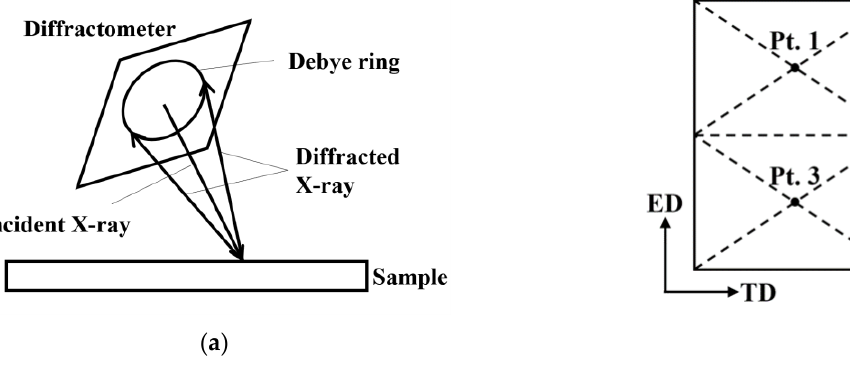
Figure 2. ( a ) Diffraction geometry of residual stress determination by X-ray diffraction and ( b ) distribution of the residual stress testing points of the AZ31B magnesium alloy plates.